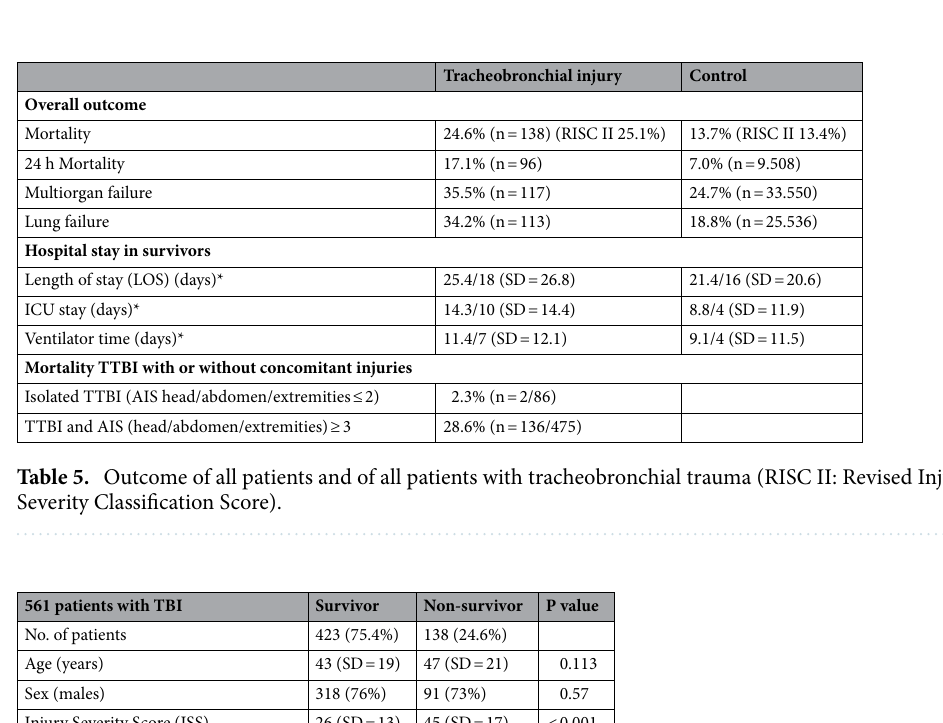
Table 4. A: Surgical treatment of patients with tracheobronchial injuries, B: Surgical treatment and mortality according to the Abbreviated Injury Scale (available in the standard documentation only). AIS Abbreviated Injury Scale.